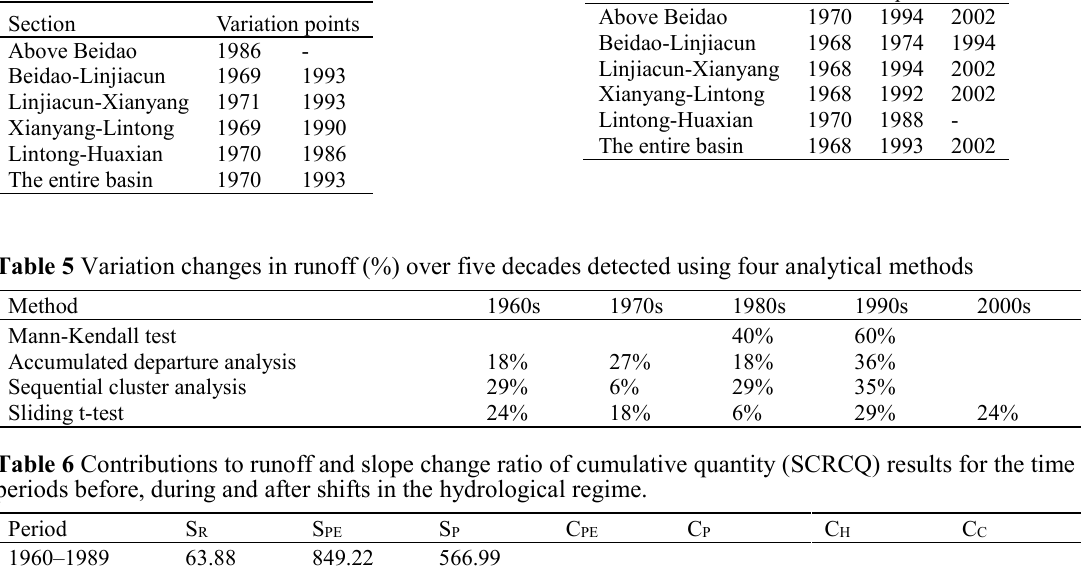
Table 2 Accumulated departure analysis results.